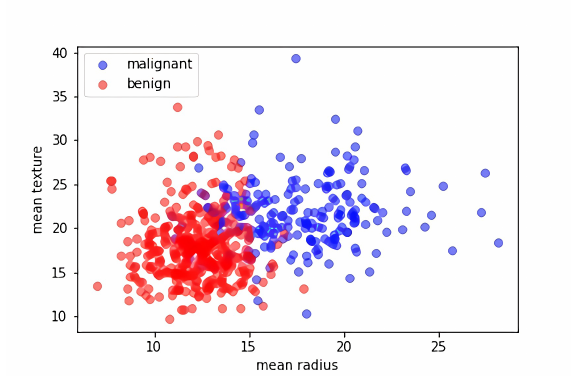
Figure 1. Class distribution on the dataset with IR=1.684